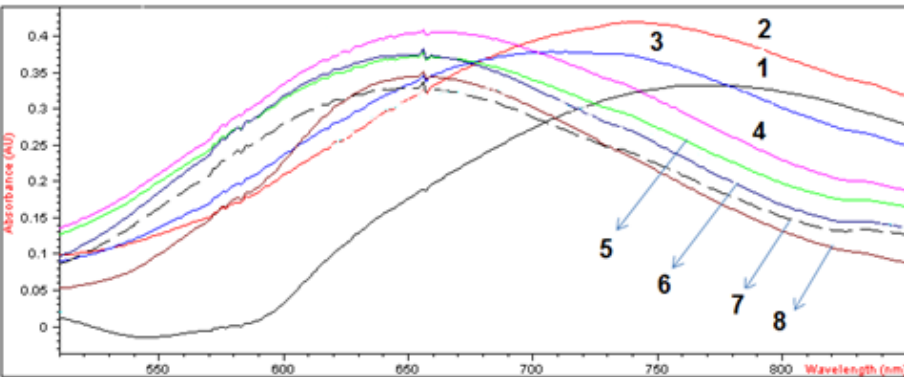
Figure 3. Spectrophotometric titration of [Cu(L 1 )Cl]PF 6 ( 1-Cl ) (5.06 × 10 − 4 M) in aqueous acetonitrile solutions at room temperature. The H 2 O/CH 3 CN volume ratios were as follows: (1) 0/10, (2) 0.3/9.7, (3) 0.6/9.4 (4) 1.5/8.5, (5) 2.0/8.0, (6) 2.6/7.4, (7) 3.3/6.7, and (8) 4.0/6.0.